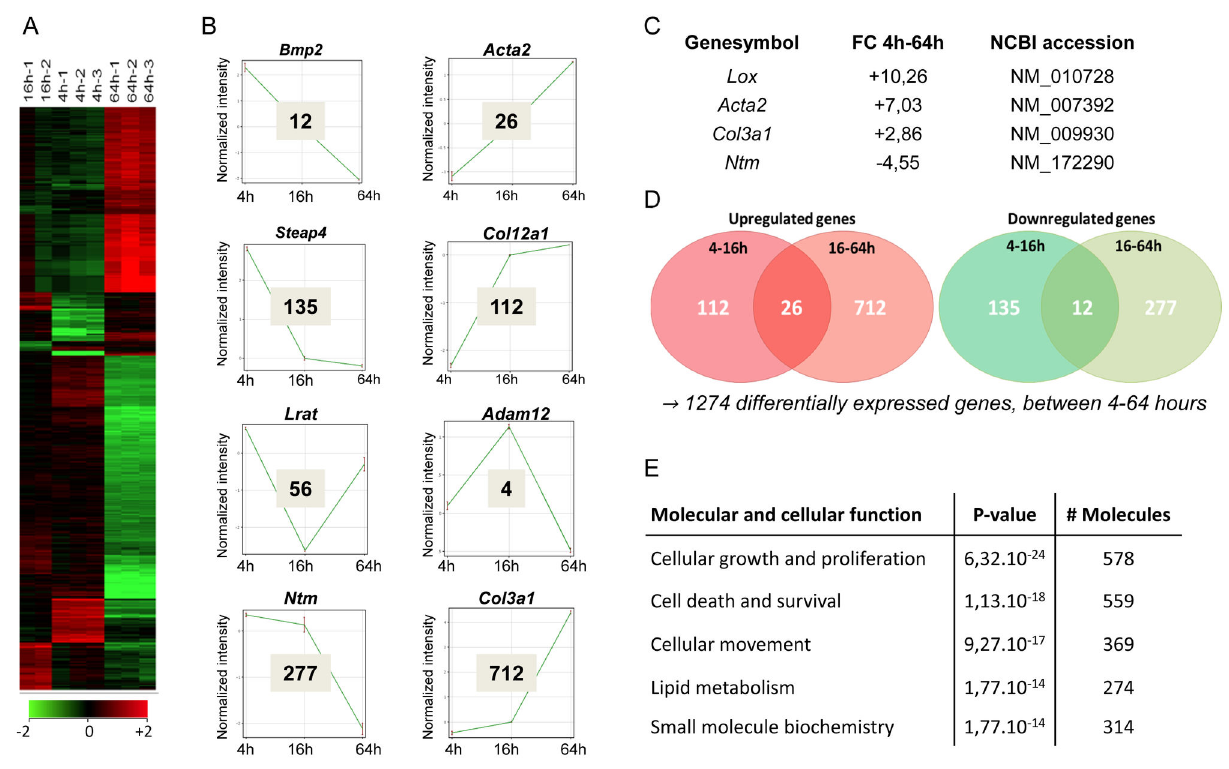
Figure 2. Gene expression pattern changes during early culture induced mHSC activation. Hepatic stellate cells were isolated from normal mice and cultured in 10% fetal bovine serum. 4 hours, 16 hours and 64 hours after washing of the cells mRNA was extracted, cRNA was generated and a microarray analysis was performed. ( A ) Shown is a representative graph of 2 or 3 separate HSC isolations per group (“1,” “2,” and “3”) containing all genes that were more than 2-fold up regulated (shown in red) or down regulated (shown in green) in at least 1 of the time points in comparison with quiescent HSCs (4h) (one-way anova, P < 0.05 followed by Benjamini-Hochberg correction). ( B ) Graphic representation of observed trends in gene expression changes during early HSC activation. Normalized intensities are shown and a known HSC associated gene is given that follows the trend. A representative gene for each trend is shown above each graph. ( C ) Table representing fold changes of known HSC activation/ quiescence markers. ( D ) The Venn diagram shows overlapping patterns of probe sets that were significantly (P < 0.05) and at least 2-fold up regulated and down regulated between 2 time points. Probe sets that were 2-fold up regulated or down regulated in one group of which the trend was continued with a 2-fold up or down regulation between 16-64h are in the intersection of the Venn diagram. ( E ) Top 5 “molecular and cellular functions” identified by Ingenuity Pathway Analysis performed with the genes from the Venn diagram